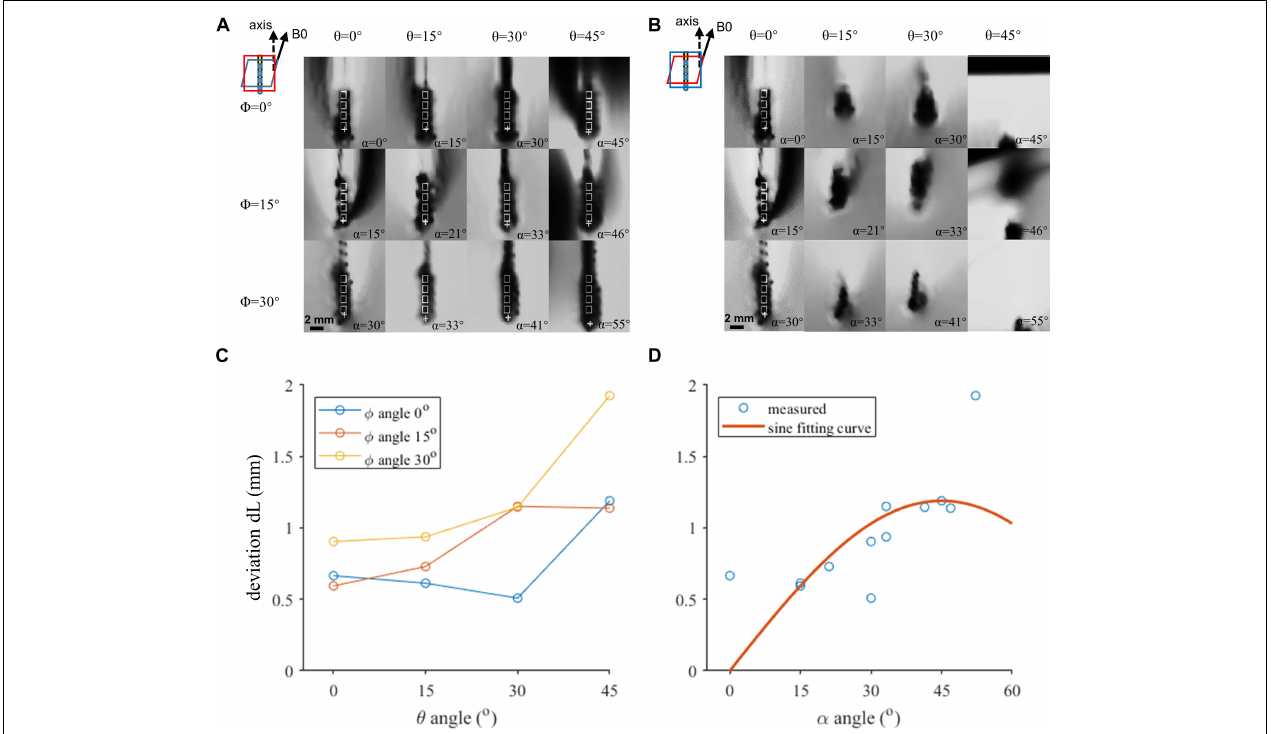
FIGURE 2 | The coronal view of the artifacts of four contacts in various orientations. (A,B) Artifact positions under different lead orientations. White rectangles indicate the outline of the contacts. Cross markers indicate the template-matched position of the proximal contact. (A) Image resliced parallel to the top surface of the rotatable fixture. (B) Image resliced parallel to the X–Z plane. (C,D) Localization deviation as a function of the axis direction. (C) Horizontal axis indicates the θ angle. Three curves represent different ϕ angles. Both θ and ϕ angles contribute to the deviation, and reduction of either of the angles can achieve a better accuracy. (D) Horizontal axis indicates α . The red plane in the zoomed-in figure shows the reconstruction plane we chose in each condition in (A,B)